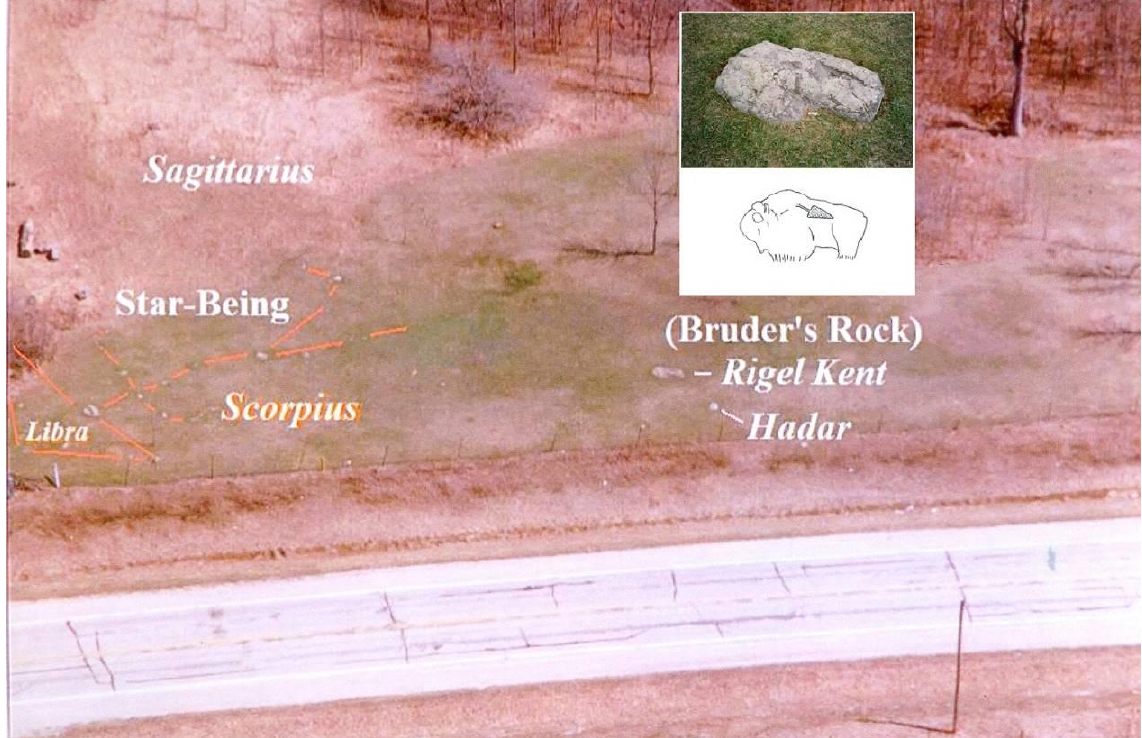
Figure 32. Aerial photograph of the Star-Being as a reflection of Scorpius and Libra with the two bison effigy rocks. Bruder’s rock (see inset) is identified as the bright star Rigel Kent ( alpha Centauri ), the smaller one to the south-west of it identified as the star Hadar ( beta Centauri ). The constellation Centaurus is no longer visible at the northern latitude of the Star-Being site, a consequence of precession of the equinoxes. View is looking east with north to the